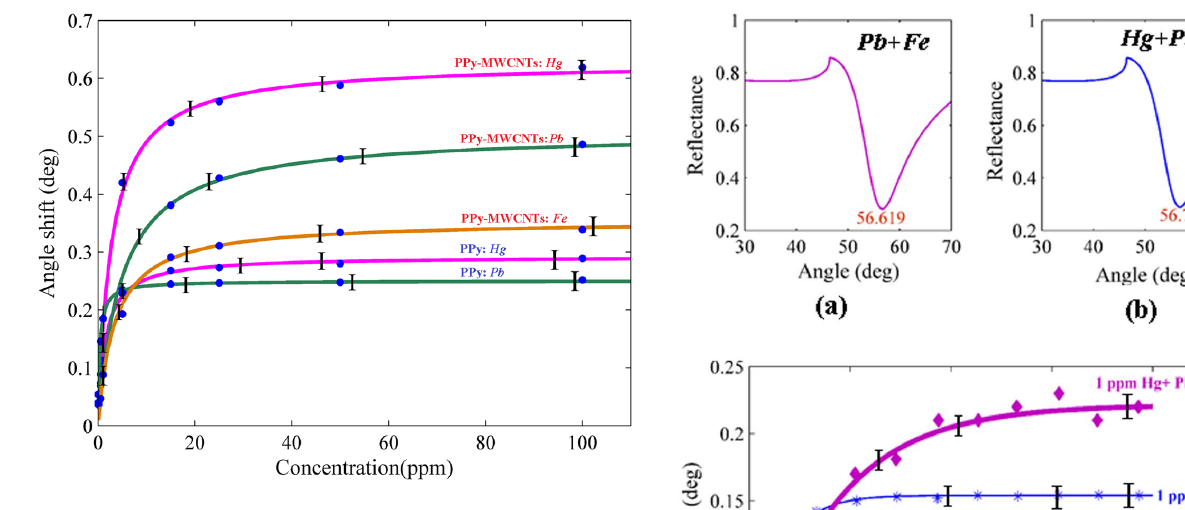
Figure 10. Angle shift at saturation value versus the concen- tration of ions for determination of the ion value in aqueous solution.